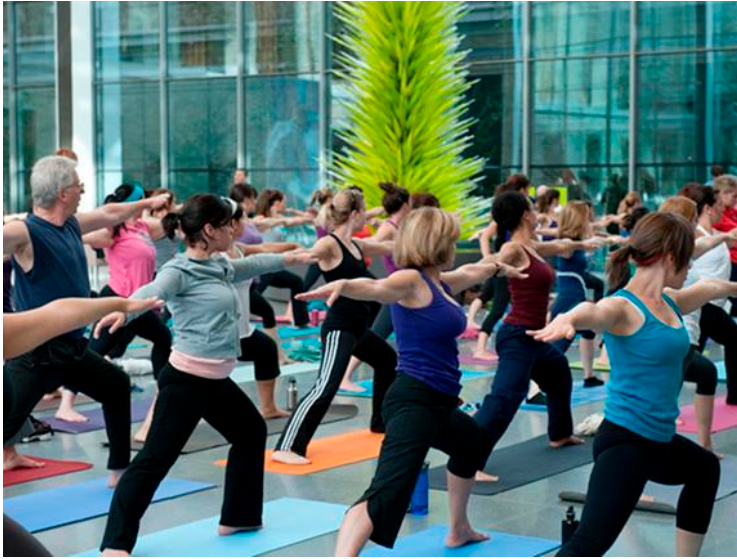
Figure 7. Namaste Saturday at the MFA. Photo Source: mfa.org.